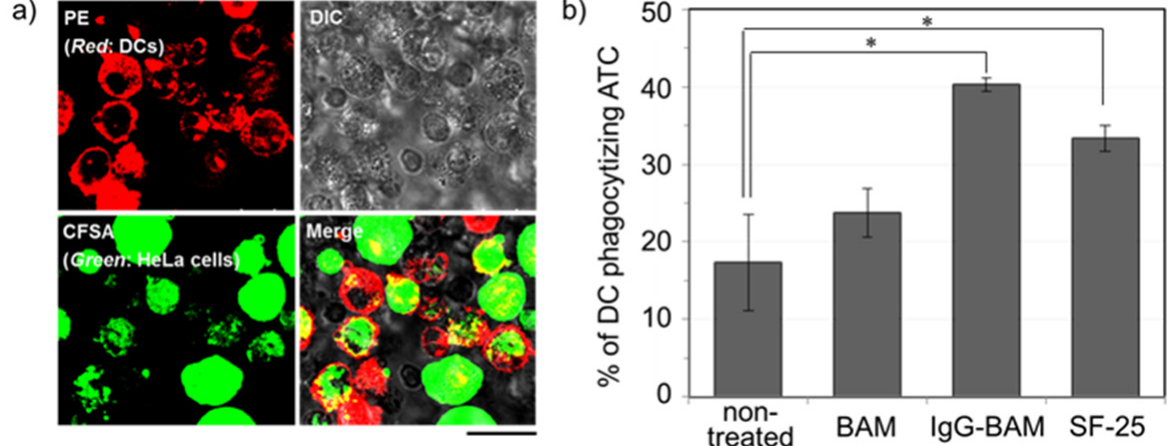
Figure 4. Analysis of the effects of the incorporated IgG-BAM on phagocytosis by DCs; ( a ) CLSM image of the DCs co-cultured with the ATCs treated with IgG-BAM. Bar = 20 mm; ( b ) The ratio of DC phagocytizing ATC analyzed by flow cytometry. (n = 3, * p <